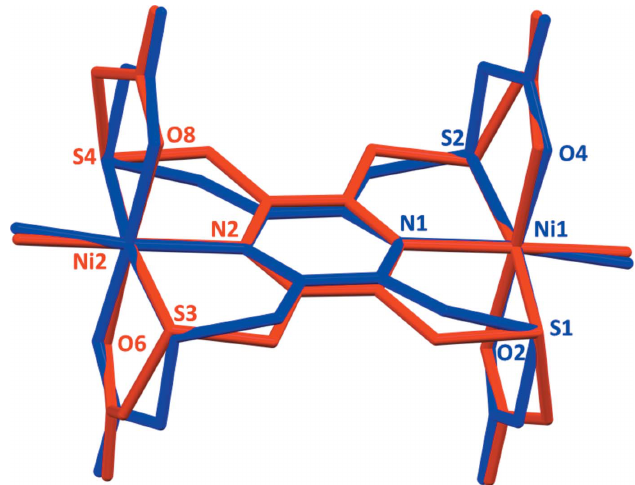
Figure 2 Molecular overlap of the two independent complex molecules of I ( Mercury ; Macrae et al. , 2020). (Molecule 1 involving atom Ni1 is in blue; Molecule 2 involving atom Ni2 is in red.)